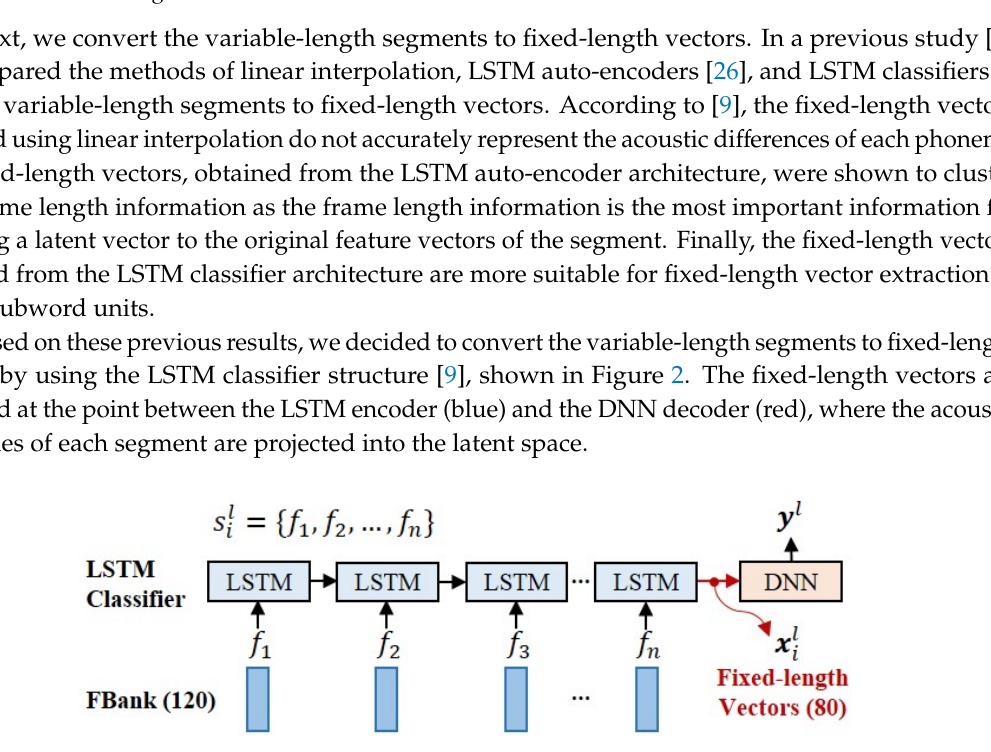
Figure 2. LSTM structure for fixed-length vector extraction.